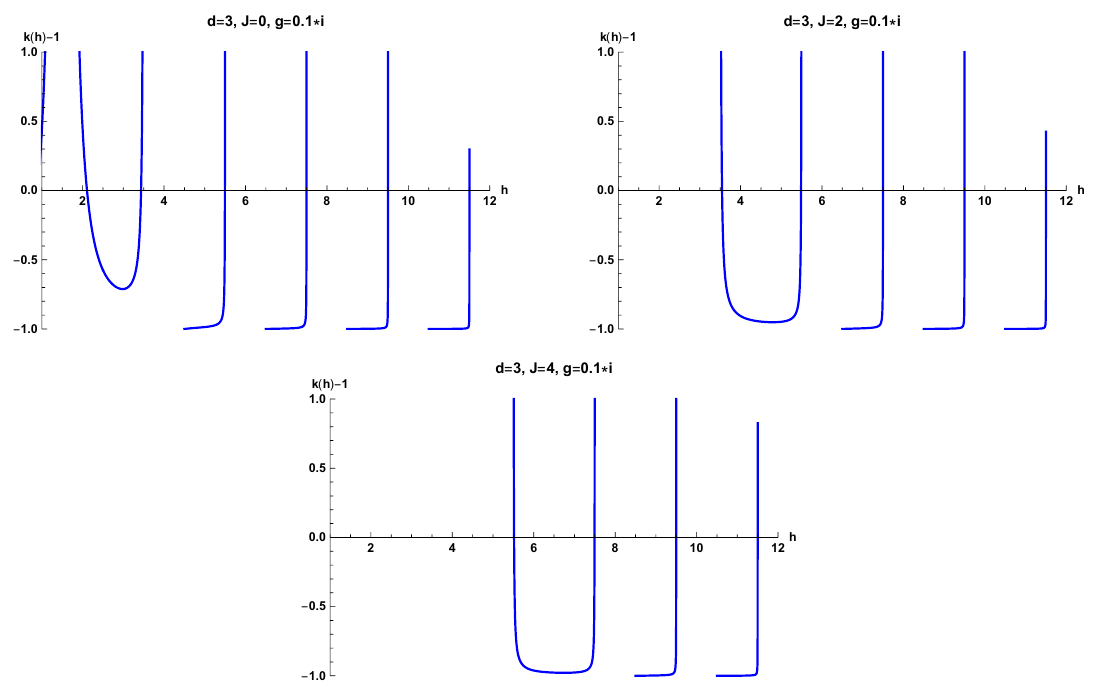
Figure 4 . Plots of k ( h )